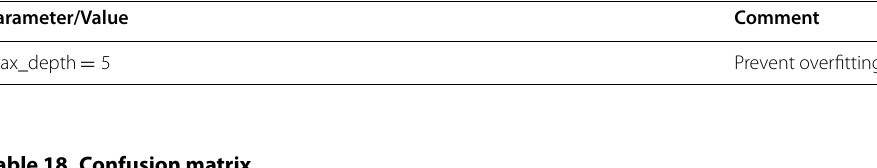
Table 17 Supervised ranking classifier Decision Tree initialization options